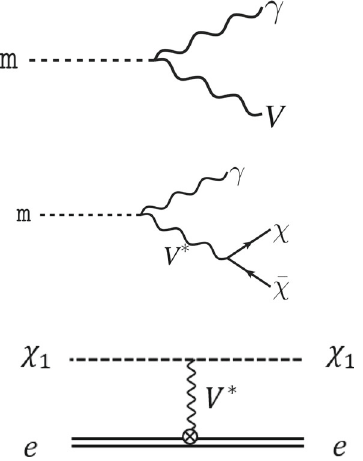
Fig. 18 Production of fermionic DM via two-body pseudoscalar meson decay m → γ V , when M V < m m (top) or via three-body decay m → γχχ (center) and DM-electron elastic scattering